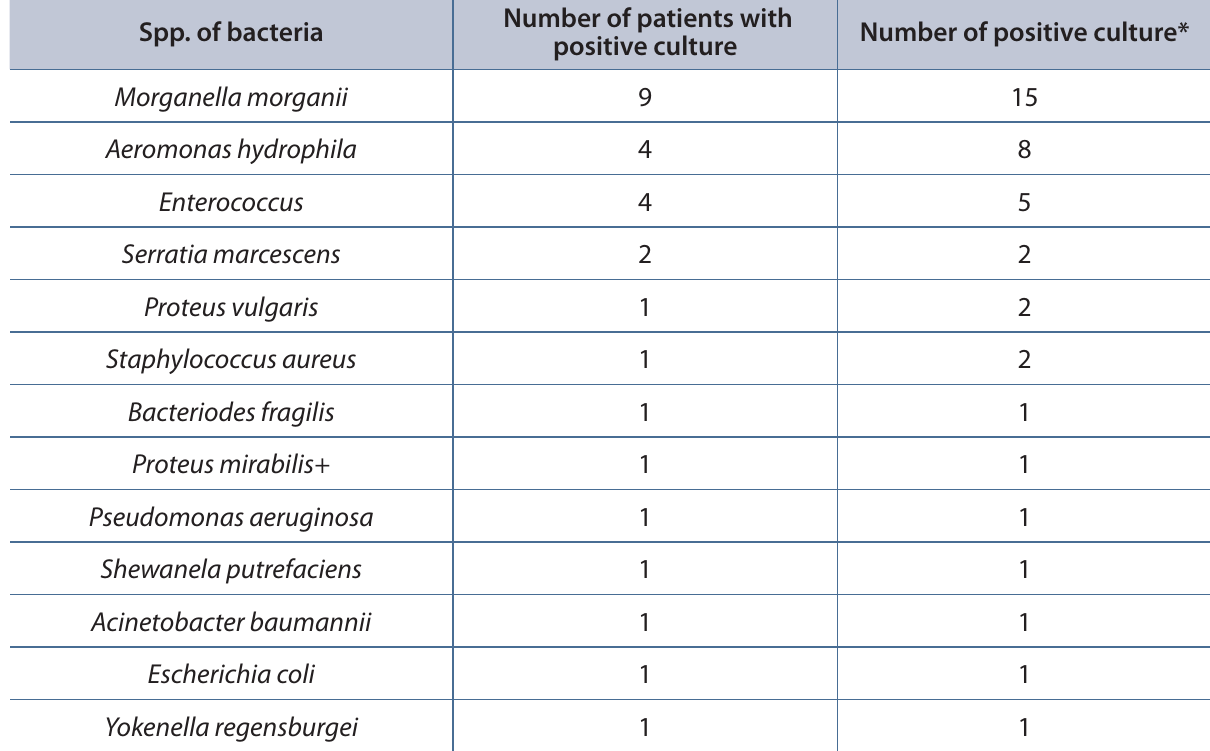
Table 2. Bacterial isolates identified in snakebite wounds Spp. of